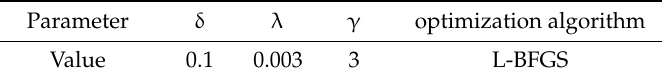
Table 3. Parameters setting of AE in this